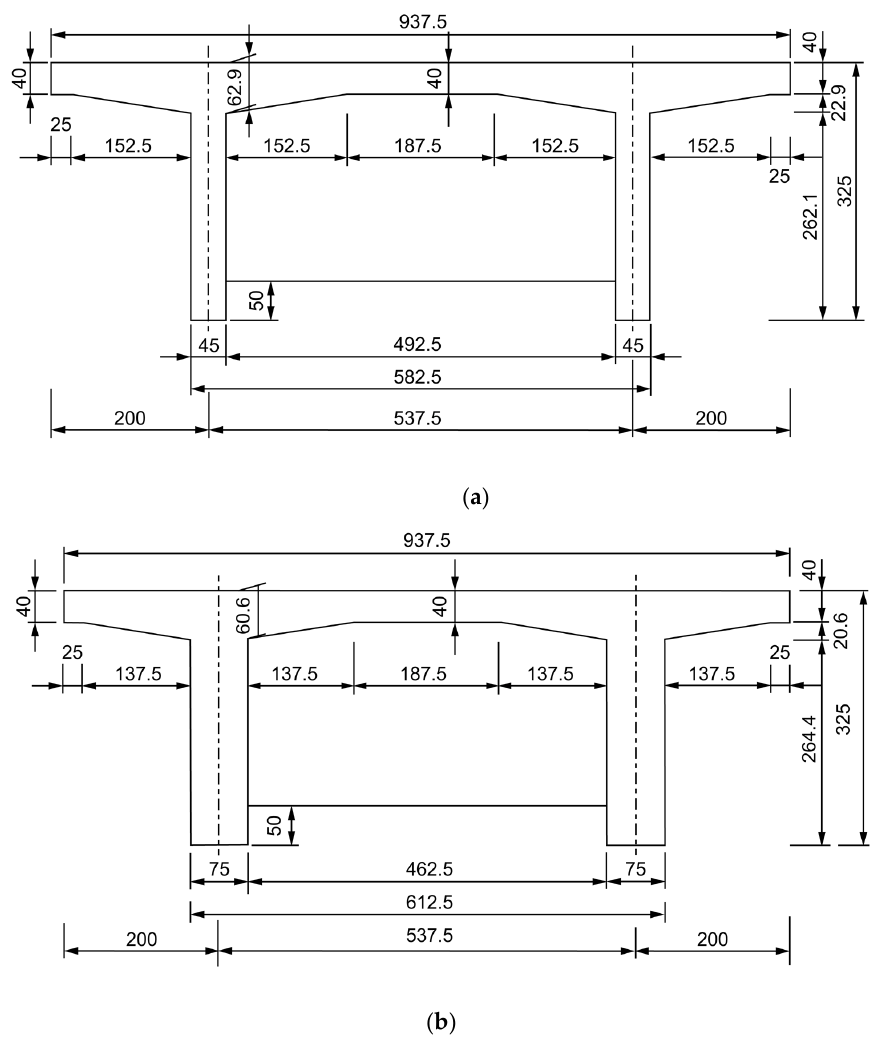
Figure 1. Cross-sectional arrangement of the test beam (mm) ( a ) Test beam midspan section size, and ( b ) Cross-sectional arrangement of the test beam support points.